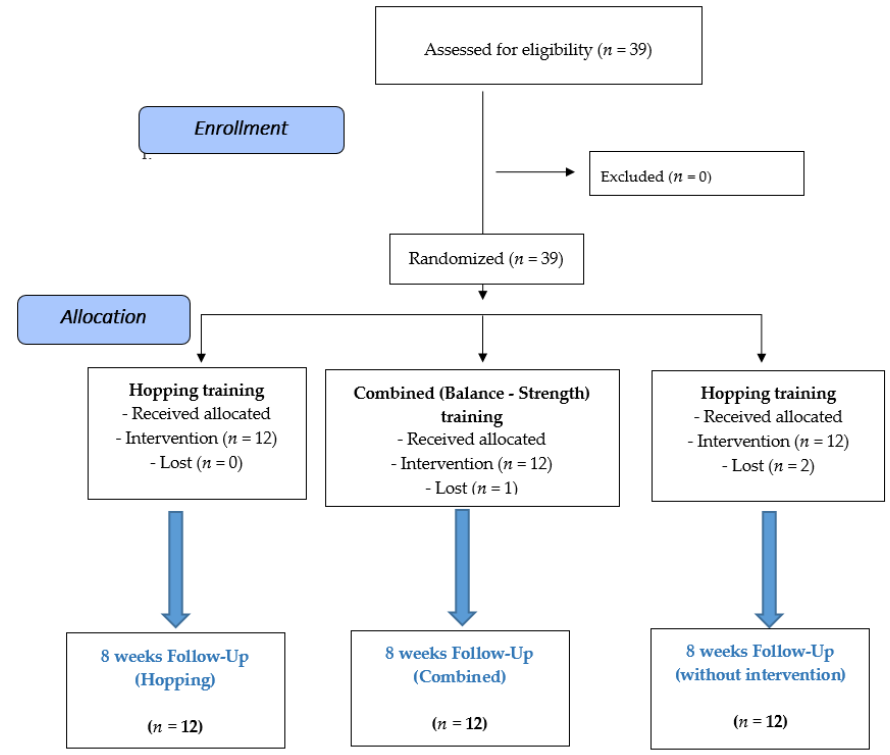
Figure 1. Transparent reporting of trials.